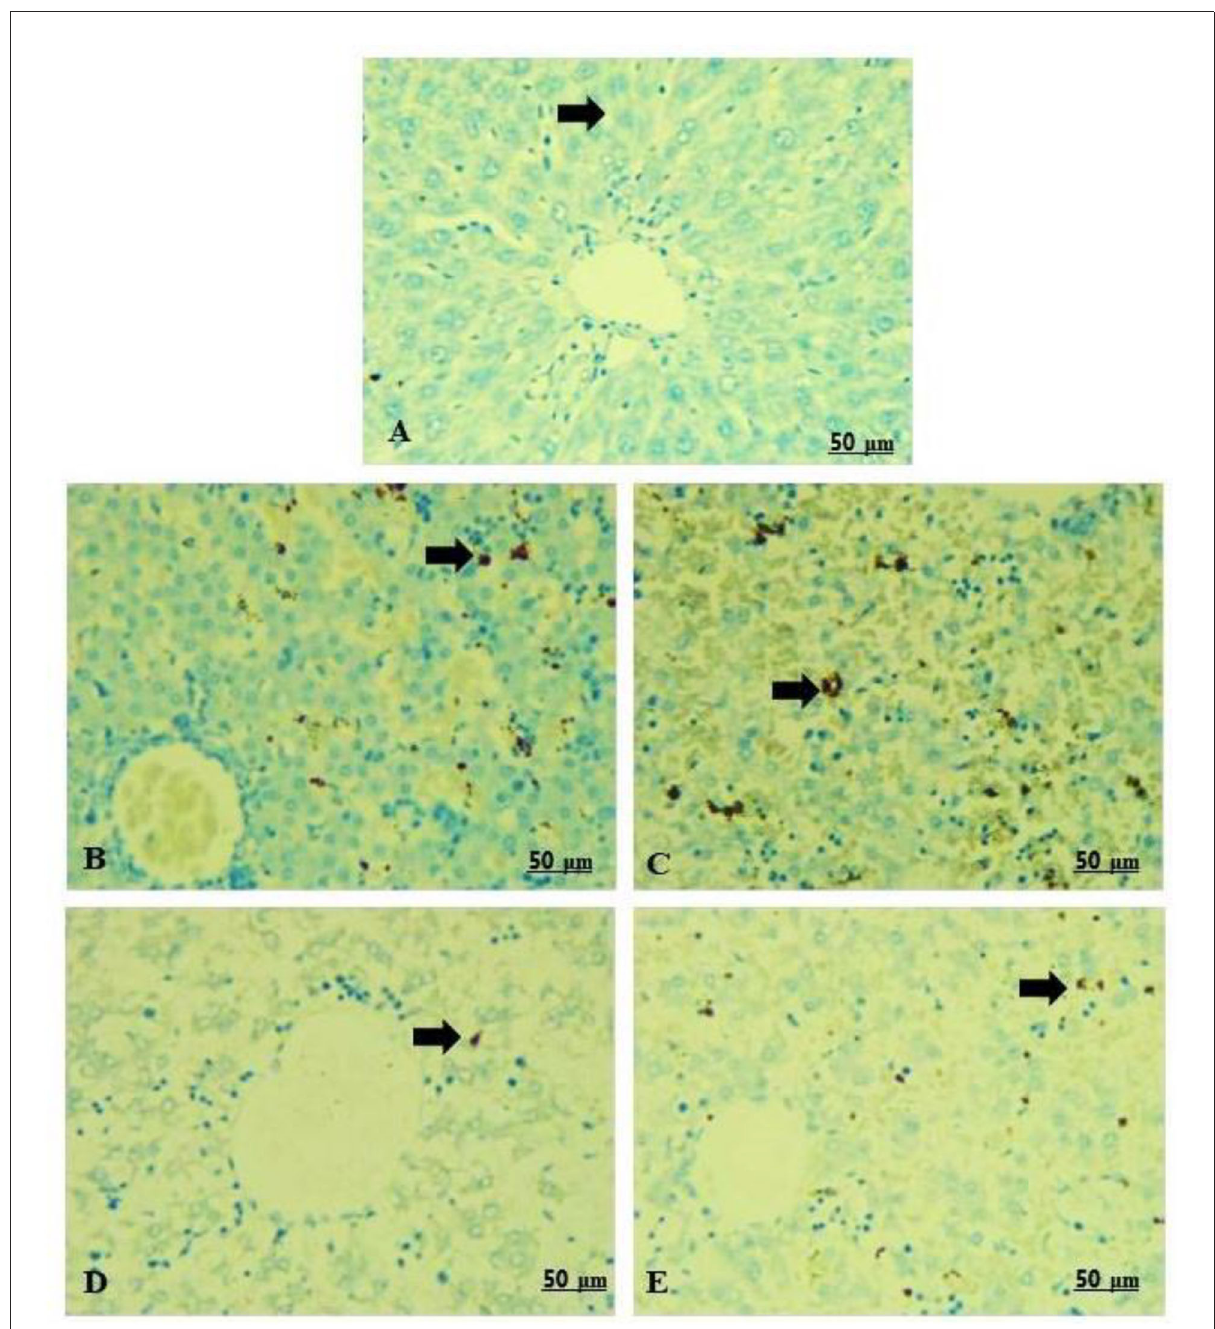
FIGURE9 (A–E) Light photomicrograph of sections from the fetal liver of control and other exposed groups by Bax-IHC: control showing negative Bax-immunostaining in the hepatocytes (A) . Groups 2 and 3 show intense positive staining reactions of Bax in the hepatocytes (B,C) . Group 4 shows negative Bax-immunoreactivity in the hepatocytes (D) . Group 5 shows a weak positive Bax-immunoreactivity in the hepatocytes (E)